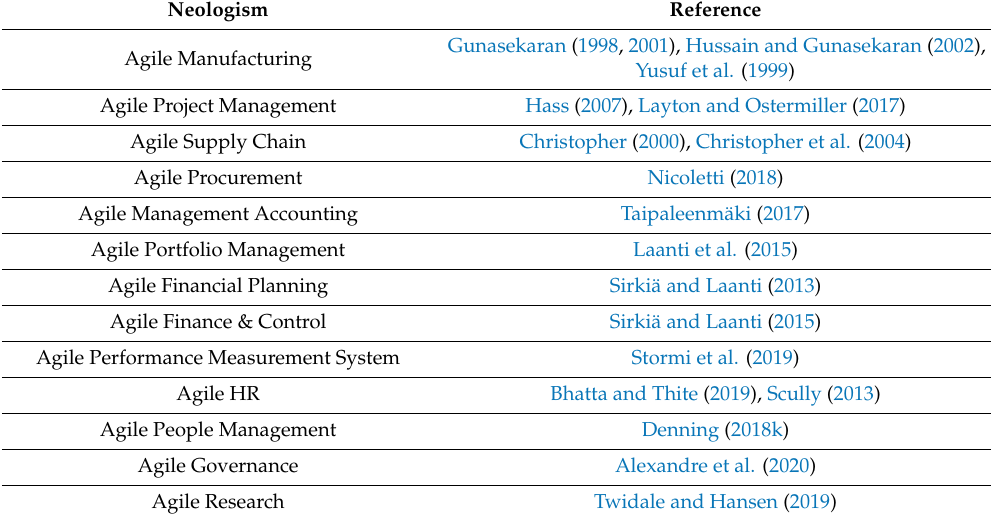
Table 1. Examples of Agile